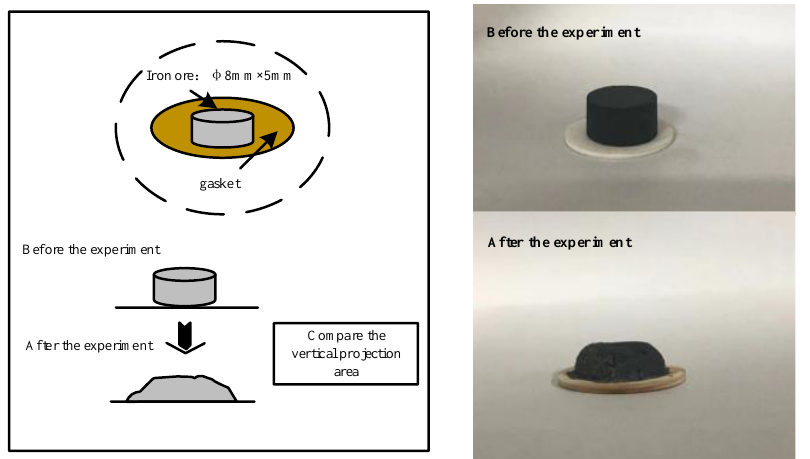
Figure 2. Schematic diagram of liquid-phase fluidity.